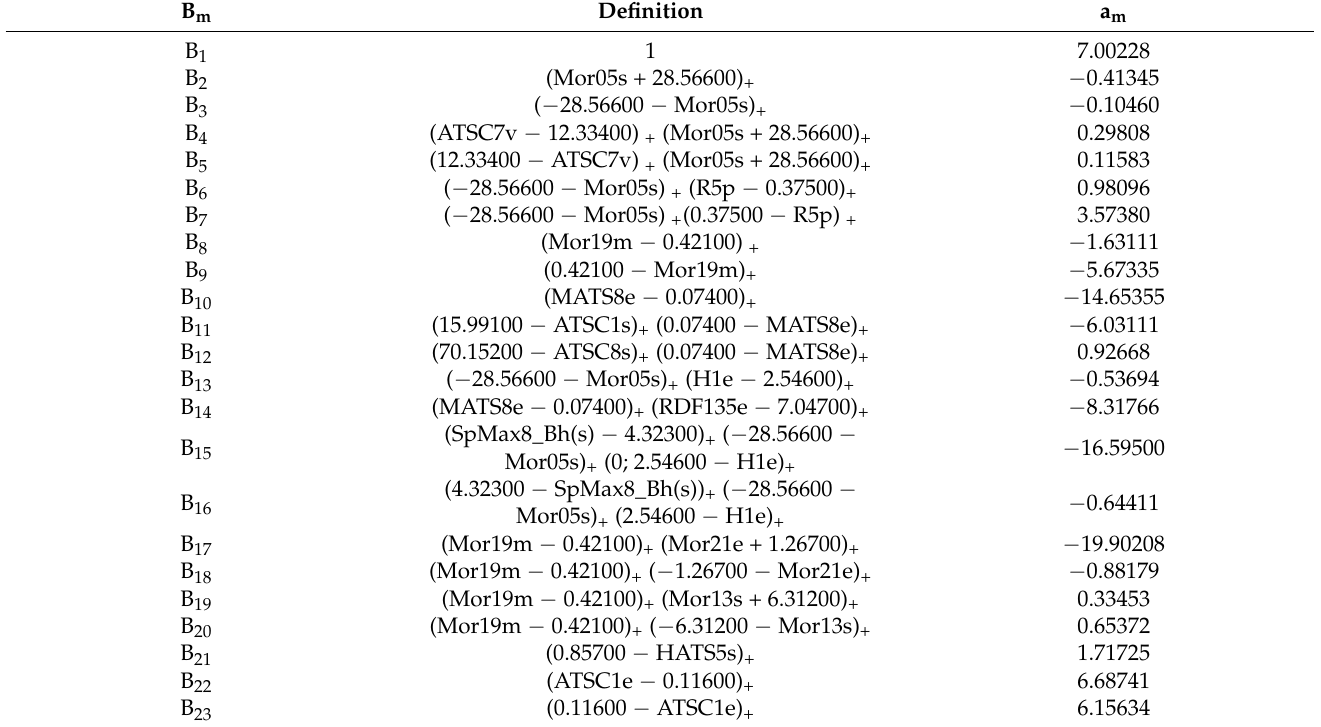
Table 3. The functions of the basis